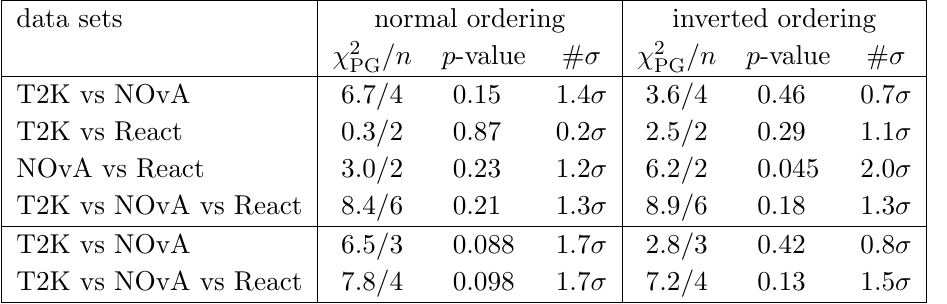
Table 2 . Testing the consistency of di(cid:11)erent data sets shown in the (cid:12)rst column assuming either normal or inverted ordering. \React" includes Daya-Bay, RENO and Double-Chooz. In the analyses above the horizontal line, (cid:18) 13 is a free parameter, whereas below the line we have (cid:12)xed sin 2 (cid:18) 13 = 0 : 0224. See text for more